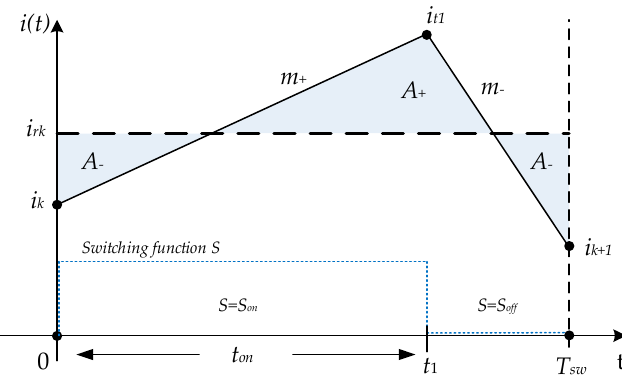
Figure 4. Time evolution of phase current 𝑖(𝑡) with respect to 𝑡 (cid:3042)(cid:3041) in a switching period.